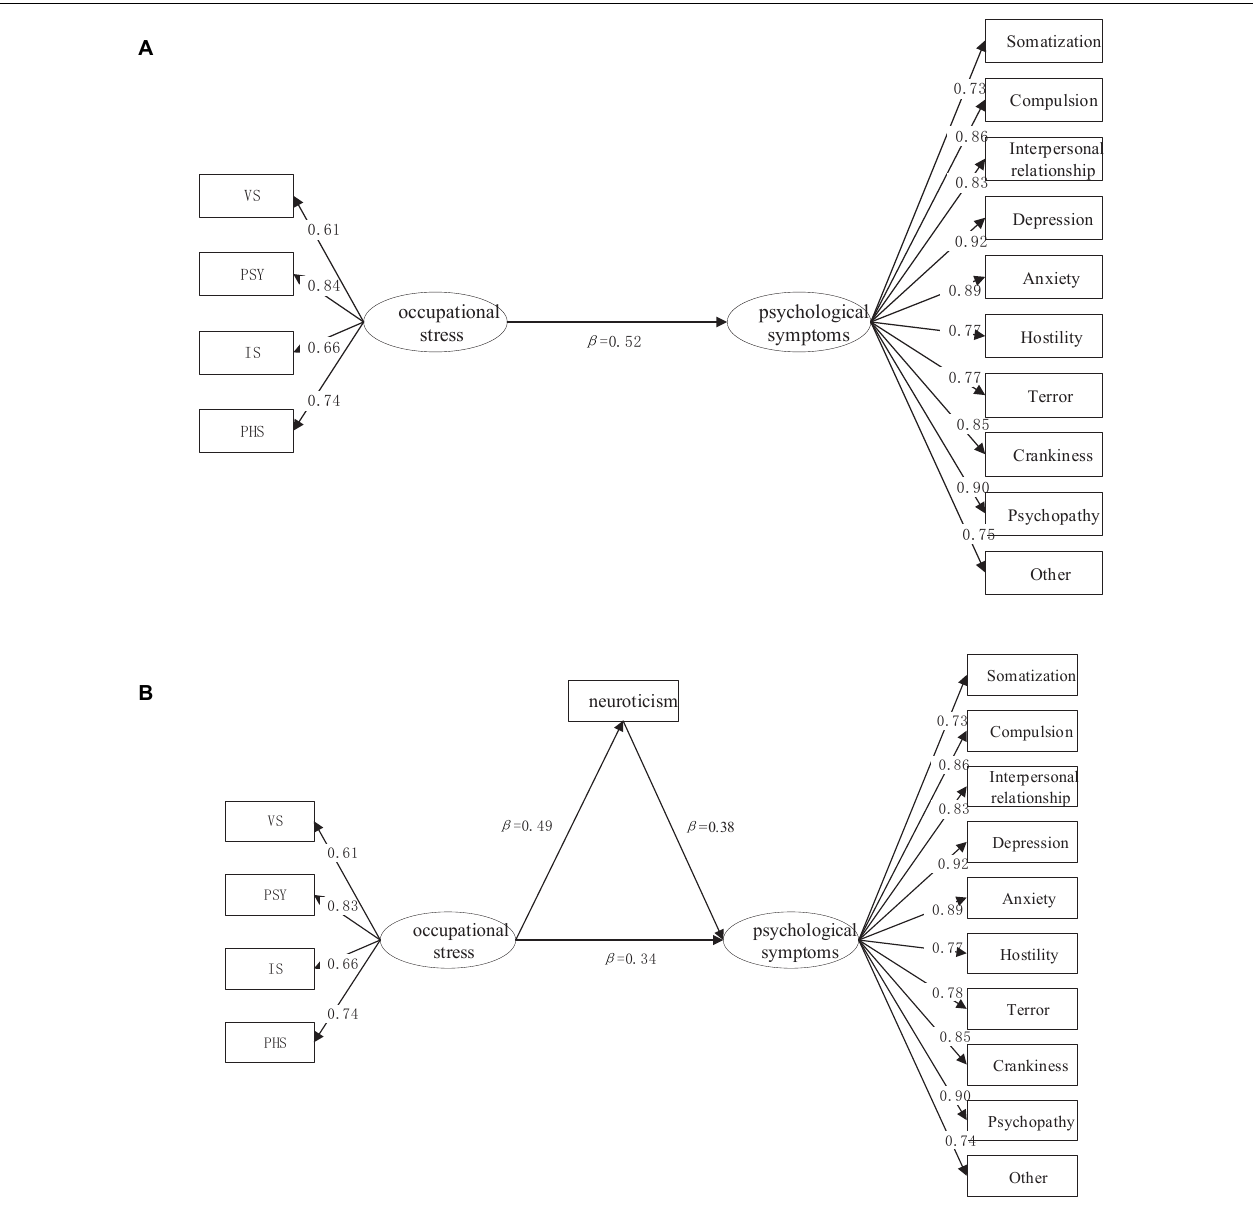
FIGURE 1 | The principle of path structural equation model: (I) sub-model (A) ; (II) sub-model (B) . The numbers listed in the figures are standardized path coefficients ( β ); continuous pathways are significant at p < 0.01.